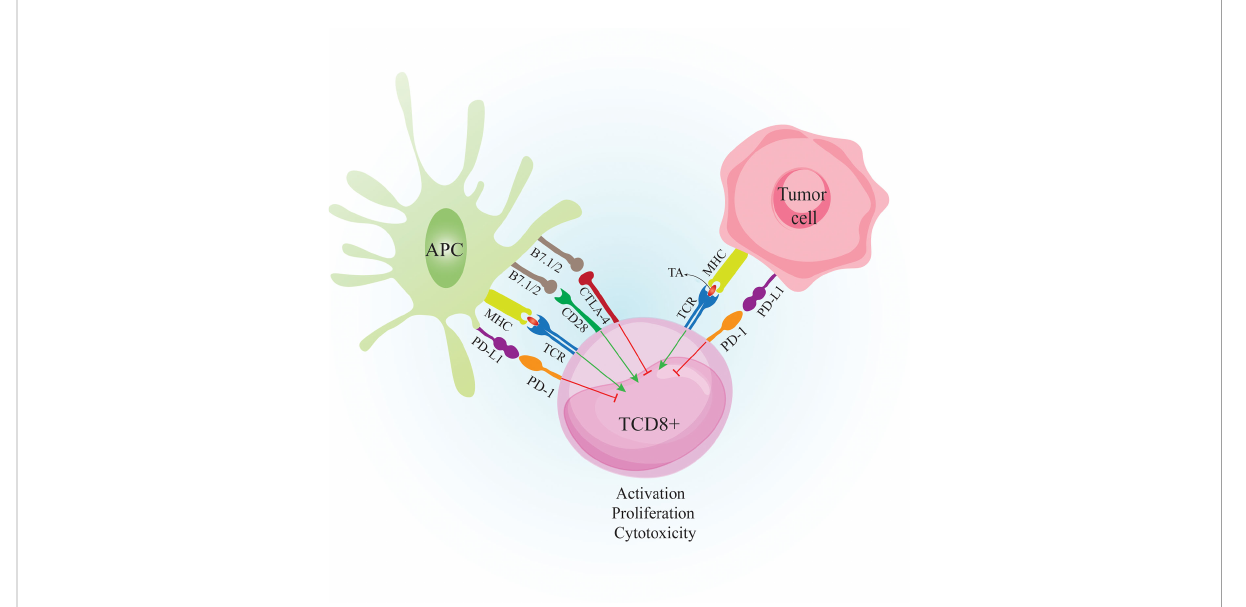
FIGURE 2 Crosstalk between CTL, APC and Tumor cell. Tumor cells are recognized by the immune system when tumor peptides are presented via APC to CD8+ T cells. APC also provide costimulatory molecules such as B7.1/2 to bind CD28 on T cells. The primed CD8+ T cells can recognize tumor antigens and destroy tumor cells by secretion of perforin and granzyme B However, tumor cells express inhibitory molecules such as PD-L1 to bind PD-1 on activated T cells to suppress anti-tumor responses. Tumor cells also induce PD-L1 expression on APCs to further suppress the immune responses. CTLA-4 is expressed on T cells following activation. Binding CTLA-4 on T cells to B7.1/2 on APCs causes inhibition of T cell activity. APC: antigen presenting cell. CTL, cytotoxic T lymphocyte; CD28, cluster of differentiation 2; CTLA-4, cytotoxic T-lymphocyte- associated protein 4; MHC-I, major histocompatibility complex class I; TA, tumor antigen; TCR, T cell receptor; PD-1, Programmed cell death 1; PD-L1, Programmed cell death-ligand